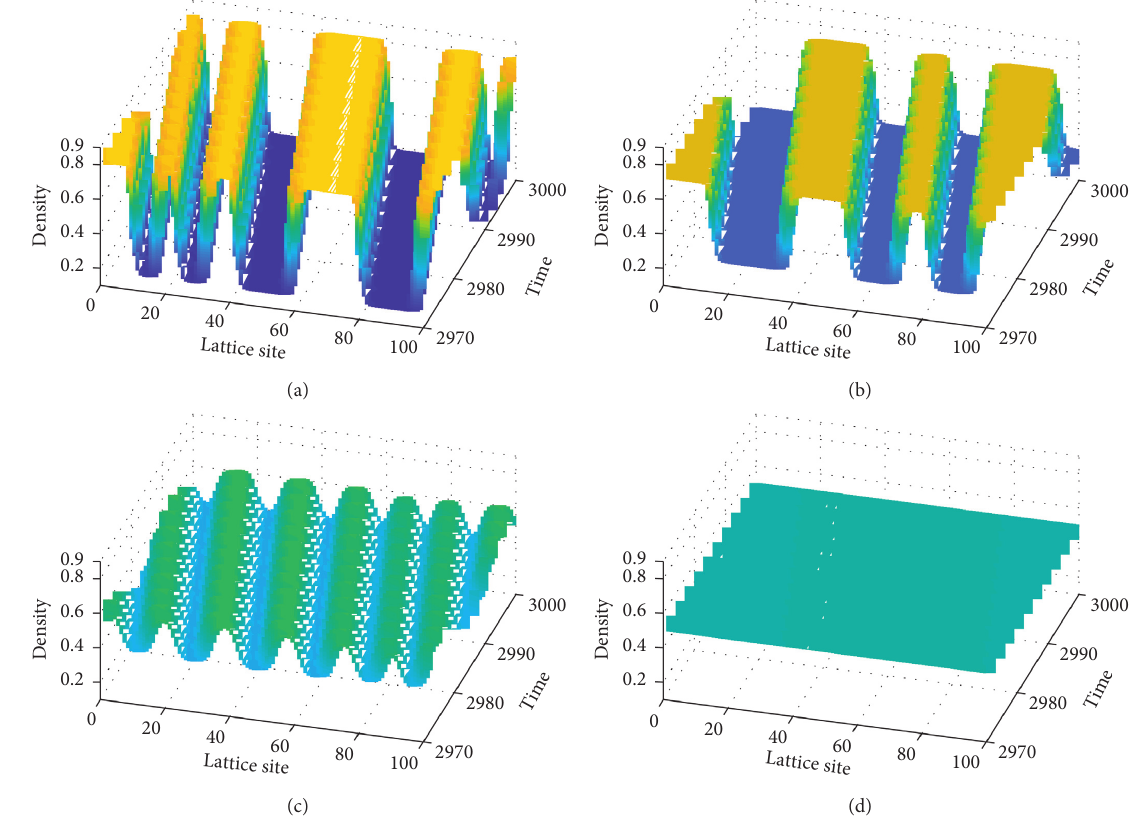
Figure 5: The phase diagram of the model according to different values of parameter λ . (a) λ � 0, (b) λ � 0.1, (c) λ � 0.2, (d) λ �